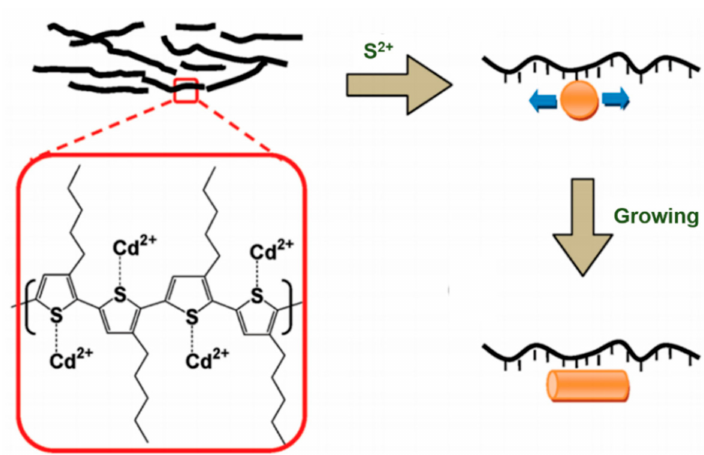
Figure 8. Schematic illustration of the growth mechanism of CdS NCs in the presence of P3HT. Reprinted with permission from [27]. Copyright 2009, American Chemical Society.